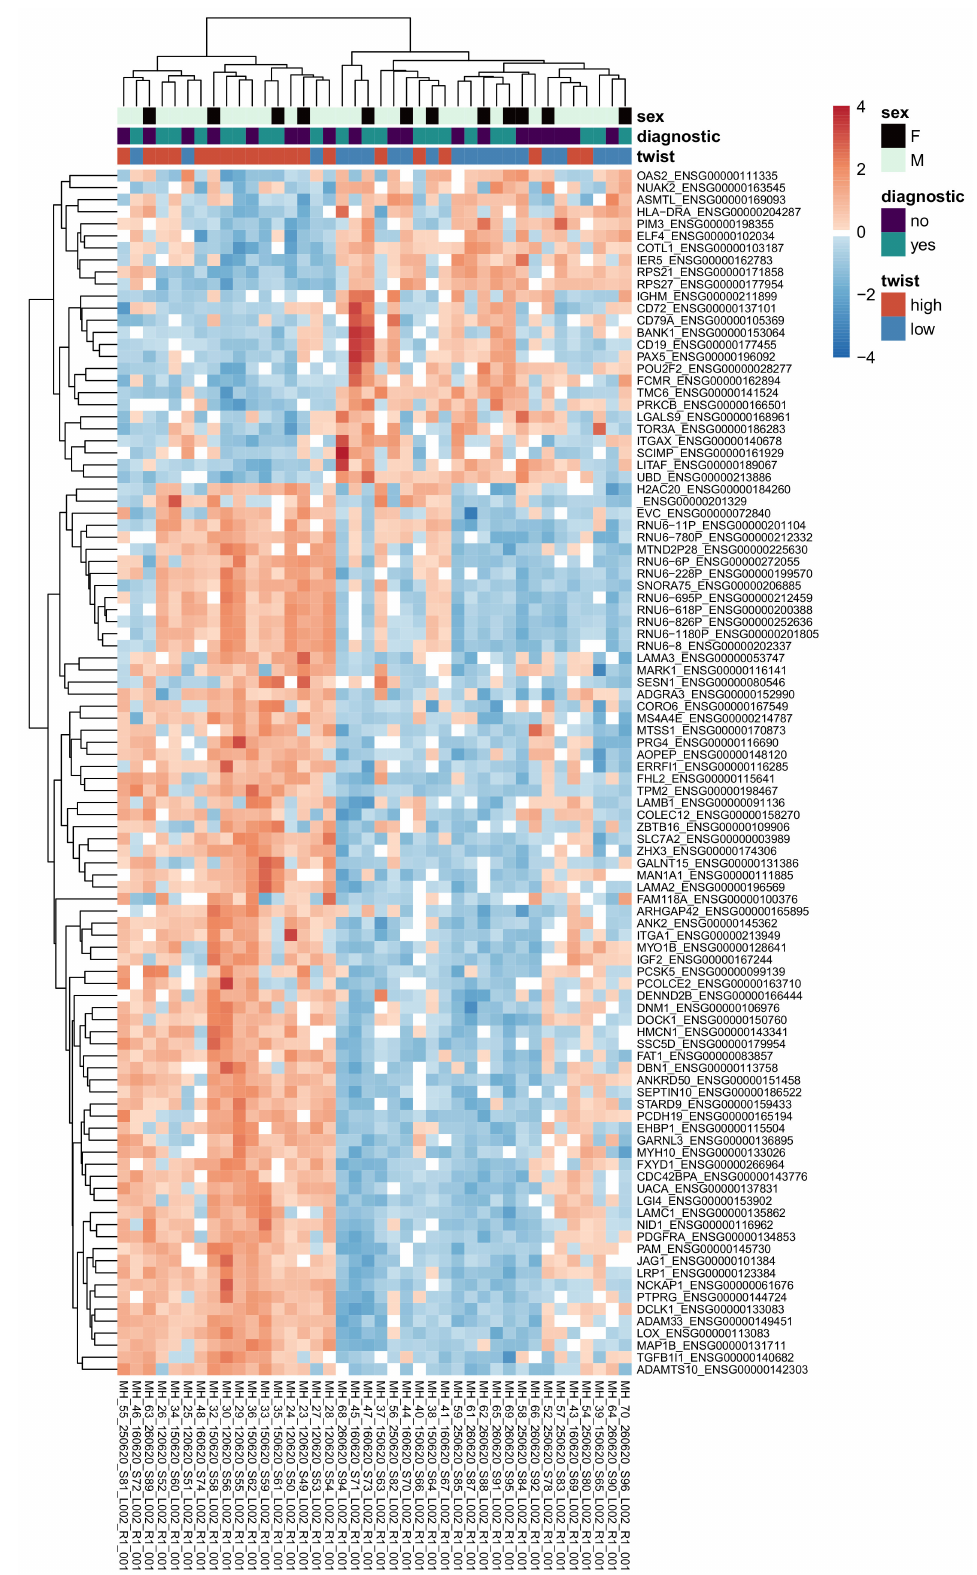
Figure 5. Heatmap of normalized read counts (with the VST method in DESeq2) for the top 100 genes according to adjusted p value, for all samples in the differential expression analysis. The rows are scaled so that blue indicates below-average expression for the gene, and red indicates above- average